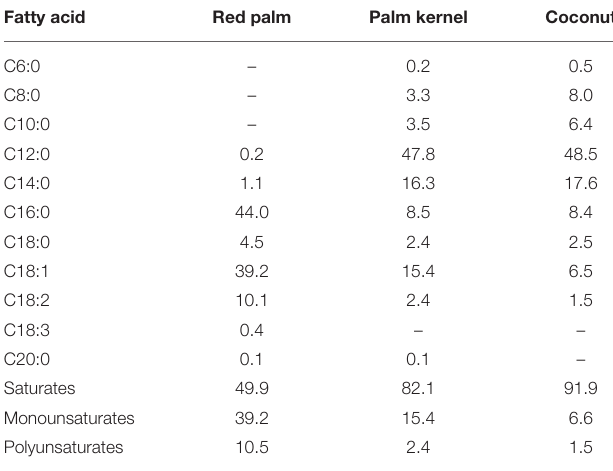
TABLE 1 | Fatty acid composition [Modified from Edem (6)]. Fatty acid Red palm Palm